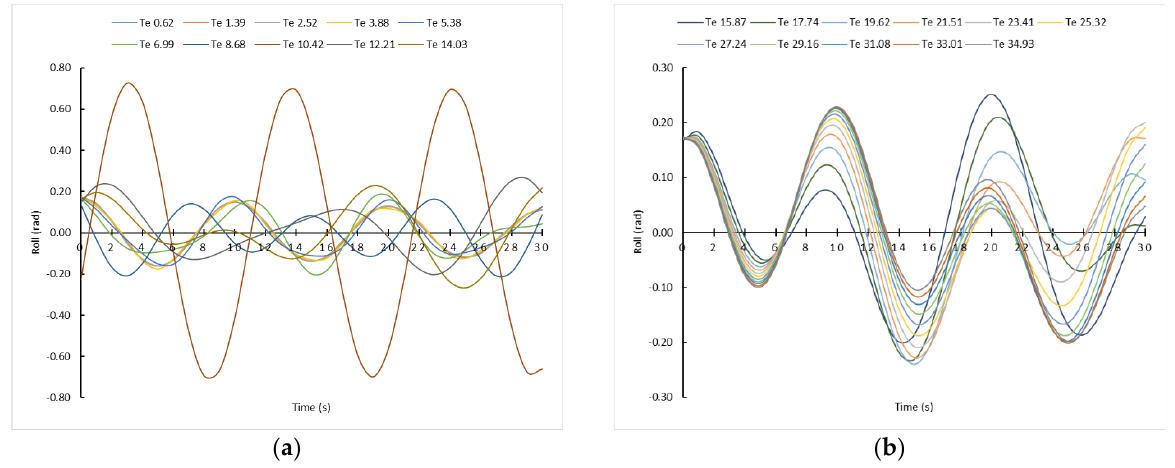
Figure 7. Rolling motion sailing at 8.0 knots and induced by waves with resistance with an α angle of 45°. Td = 10 s. θ MAX = 10°. ( a ) Te from Te 0.62 s to 14.03 s. ( b ) Te from Te 15.87 s to 34.93 s.